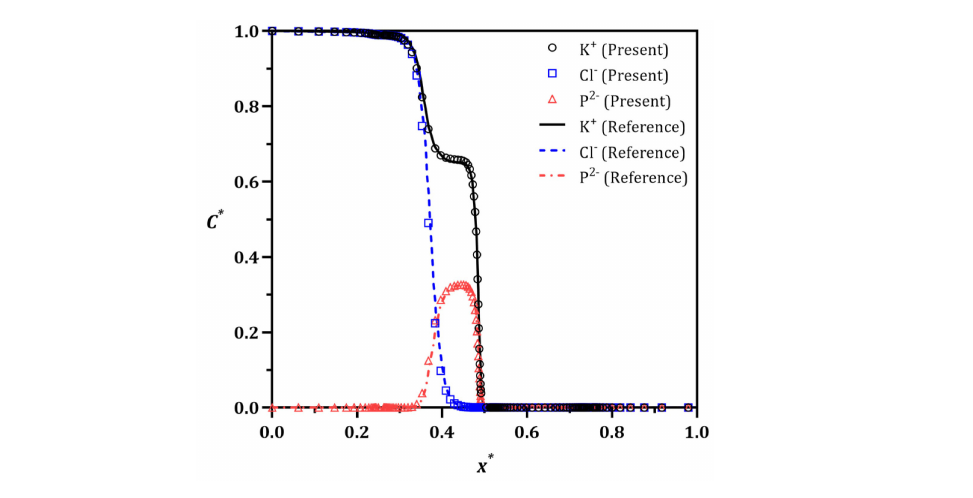
Figure 2. Validation study. The distribution of the ions concentration modeled in the present study and that of reported by Liu et al. are compared [60] after the formation of IDZ at V ∗ = 1.7. The concentration of the charged species drops before the membrane located in the middle of the channel length.